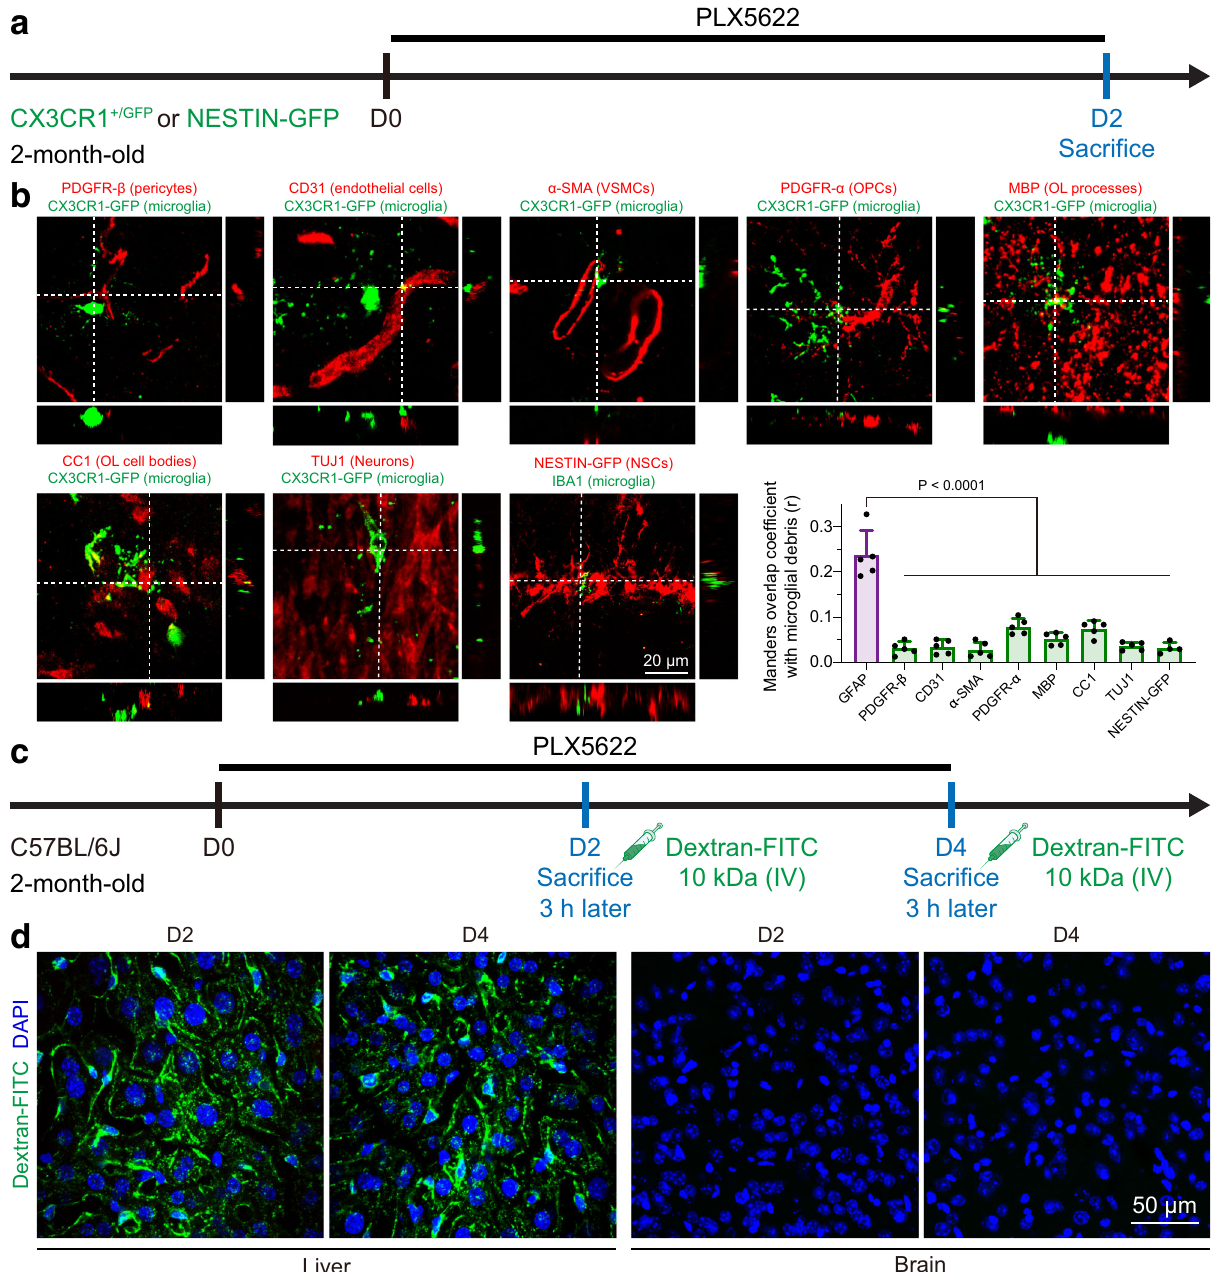
Fig. 2 | Microglial debris is unlikely to be engulfed by pericytes, endothelial cells,VSMCs,OPCs,oligodendrocytes,NSCs,neuronsorcirculatingbloodcells in vivo. a Scheme of in vivo debris engulfment examinations by microglial deple- tion. b Microglial debris is unlikely to be phagocytosed by pericytes, endothelial cells, VSMCs, OPCs, oligodendrocytes, neurons or NSCs in vivo. NESTIN-GFP is illustrated by the red pseudocolor for better visualization. Astrocytes (GFAP): 0.24±0.05%, pericytes (PDGFR- β ): 0.03±0.01%, endothelial cells (CD31): 0.03±0.01%, VSMCs ( α -SMA): 0.03±0.02%, OPCs (PDGFR- α ): 0.08±0.02%, oli- godendrocytes (MBP): 0.05±0.01%, oligodendrocytes (CC1): 0.07±0.02%, neu- rons (TUJ1): 0.04±0.01%, NSCs (NESTIN-GFP): 0.03±0.01%. N =4 mice in the